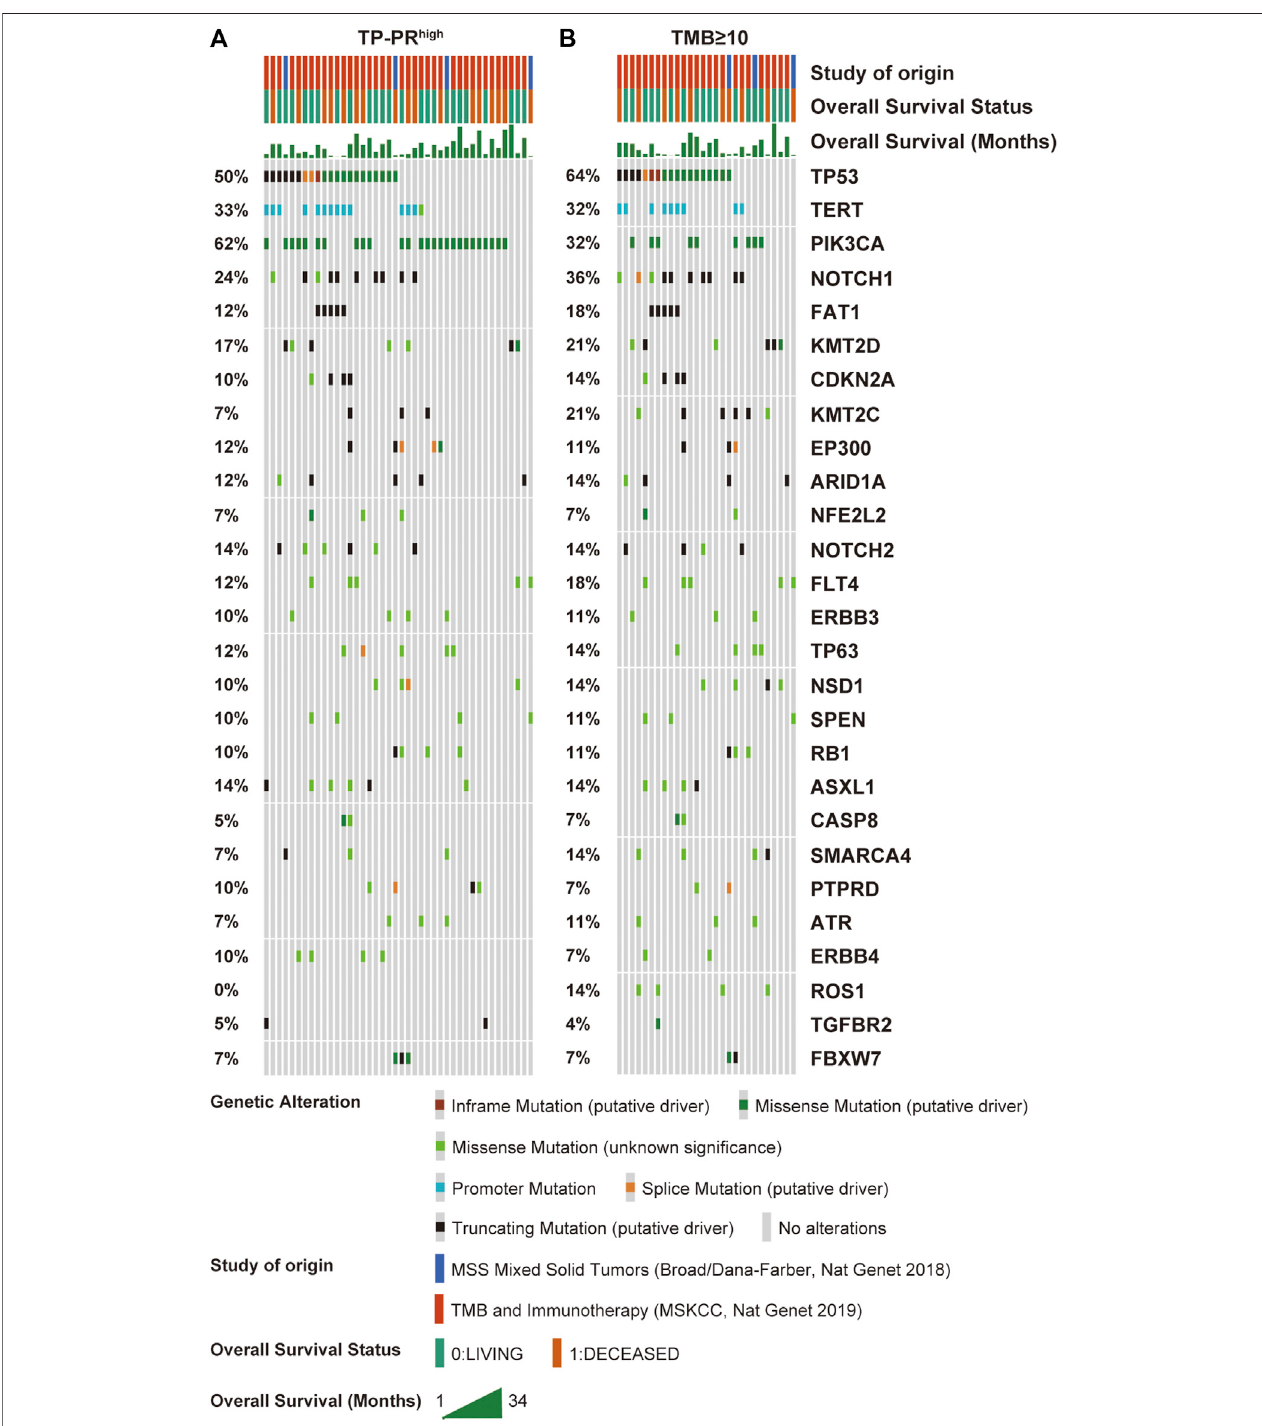
FIGURE6| MutationallandscapeofhighTP-PRvs.highTMBinICI-treatedr/mHNSCCpatients.Genemutations (A) andtheirproportions (B) areshown.Speci fi c mutationtypes are displayed indifferent colorsand shown inthe bottom panel. TMB, tumor mutationalburden; ICI,immunecheckpoint inhibitor;r/m HNSCC, recurrent and metastatic head and neck squamous cell carcinoma.